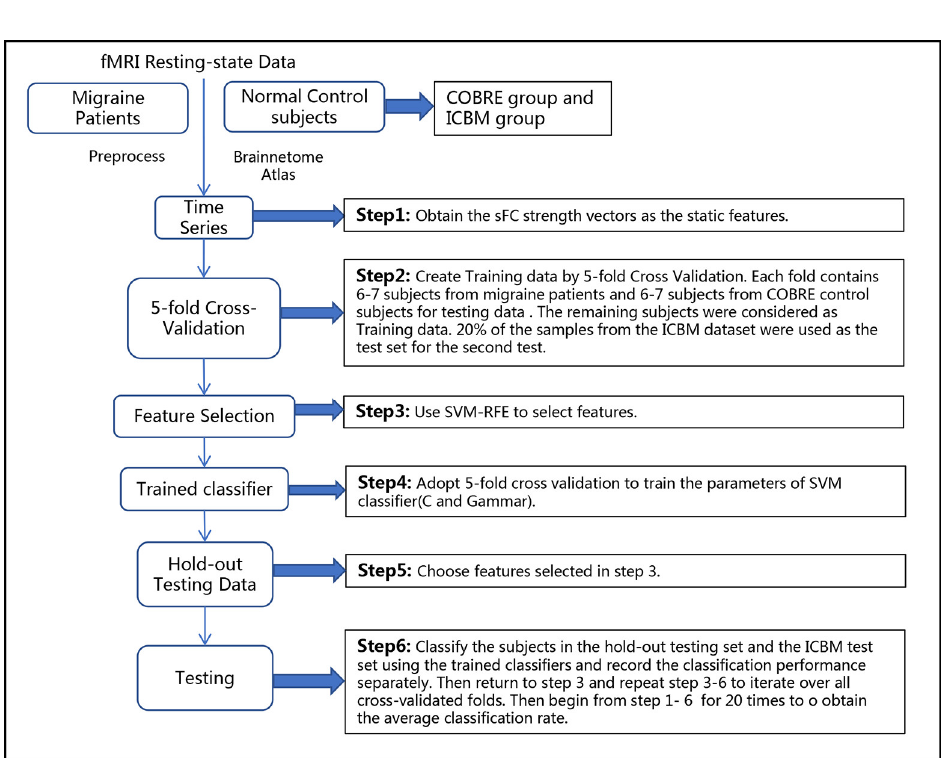
Figure 1. The framework of the classification approach based on sFC